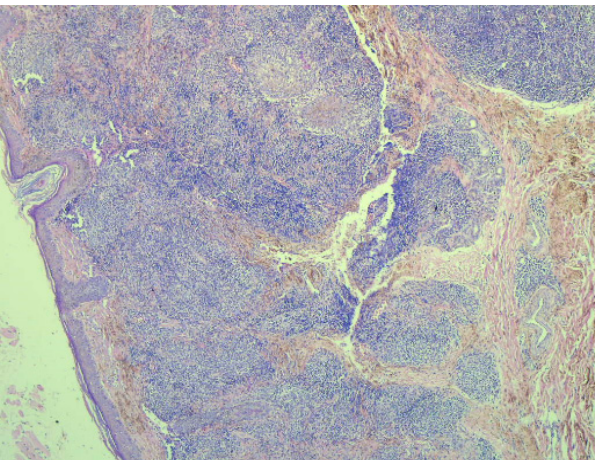
Figure 1. Nodular B-cell pseudolymphoma. ( a ). Prominent lymphocytic infiltrate with nodular (predominant) and diffuse architecture encompassing the superficial and deep dermis near dermo-epidermic junction, with extension in the periadnexal and perivascular area, without epidermotropism. Reactive follicles contain irregular reactive germinal centers with tingible body macrophages (HE 10x). ( b ). Dense lymphoid cellularity towards dermis and hypodermis, located perifollicular in the multinodular pattern (predominant), sparse epidermis. (HEx10).